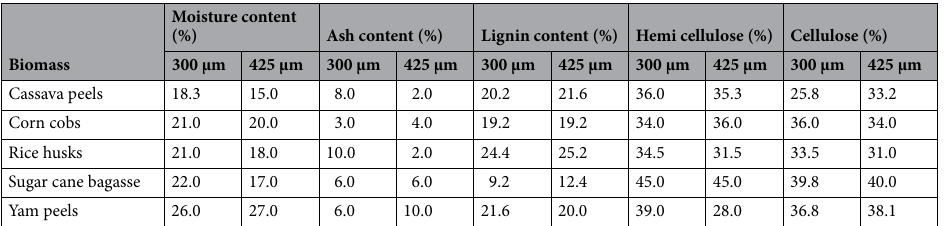
Moisture content (%) Ash content